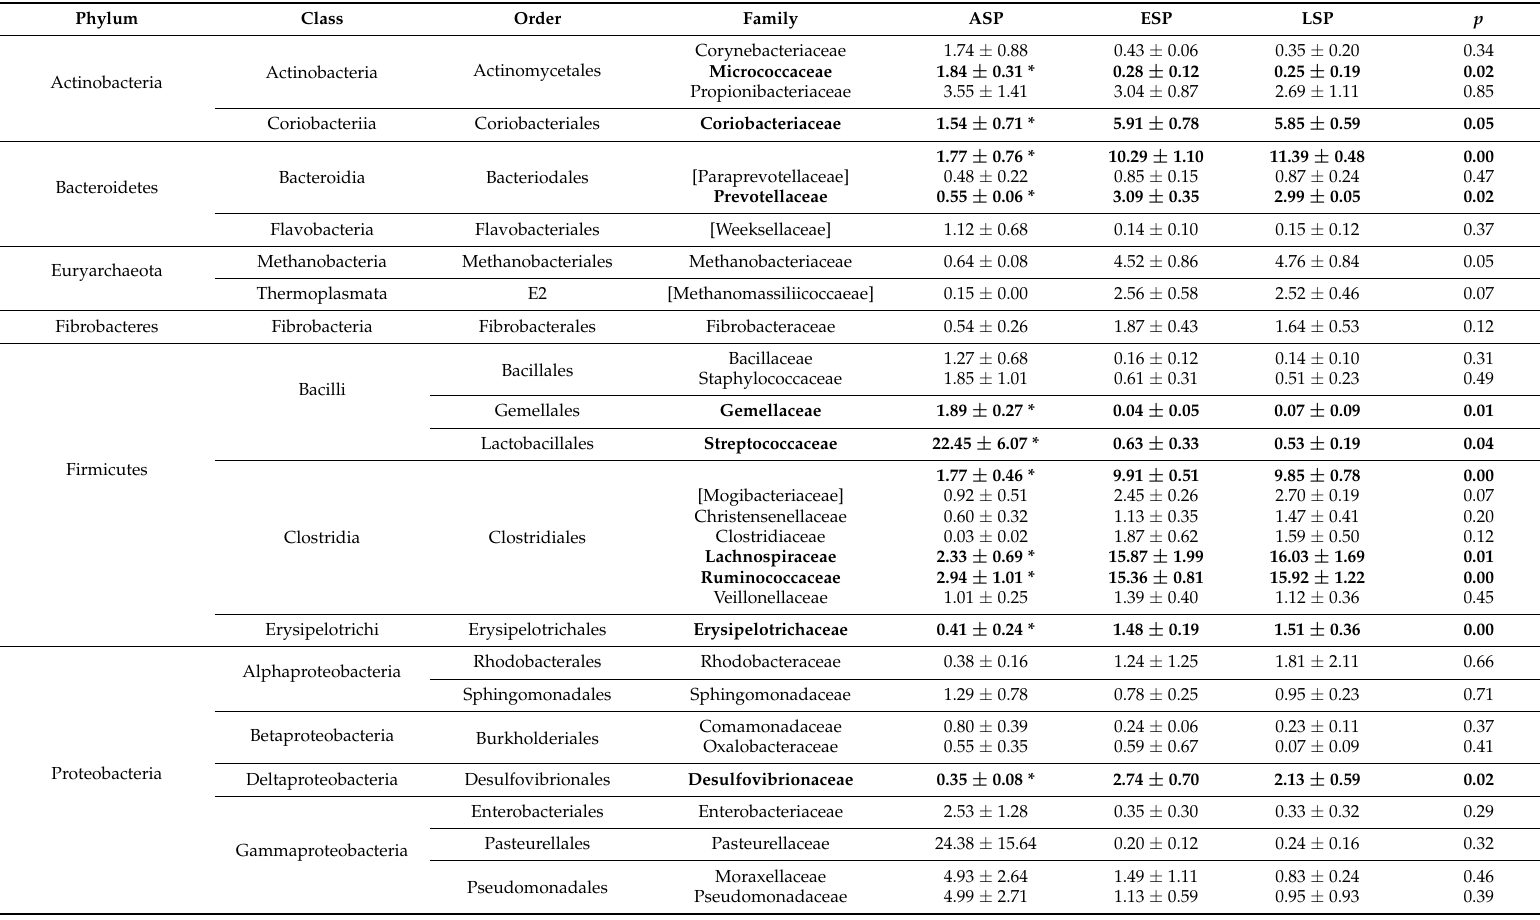
Table 3. Taxonomic relations and relative abundance, with standard deviation, of OTUs at family level in leaves. p value is indicated for One-Way ANOVA, followed by Tukey’s exact post-hoc test, carried out to determine significant differences between abundances. Significant differences are highlighted by bold text, and * indicates which result is different from the